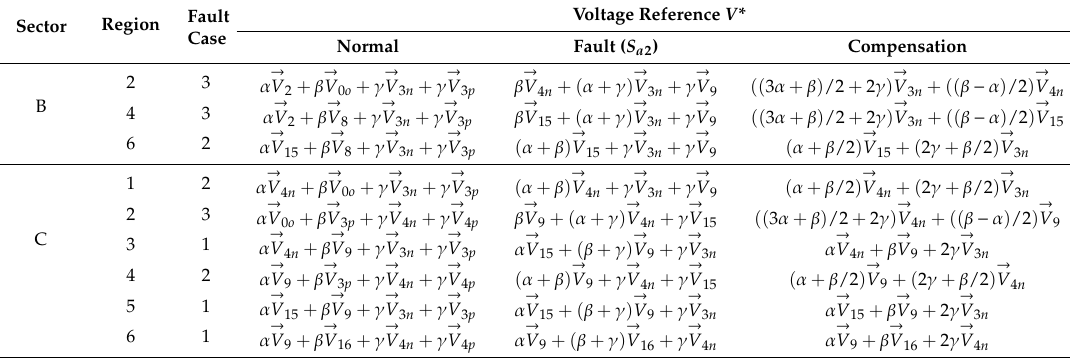
Figure 10. Reference voltage and switching patterns under the fault case 3. ( a ) Distortion and compensation of the reference voltage; ( b ) Switching pattern under the fault condition; ( c ) Switching pattern with the proposed fault-tolerant control method. Table 3. Reference voltage according to the regions of sector B and C.